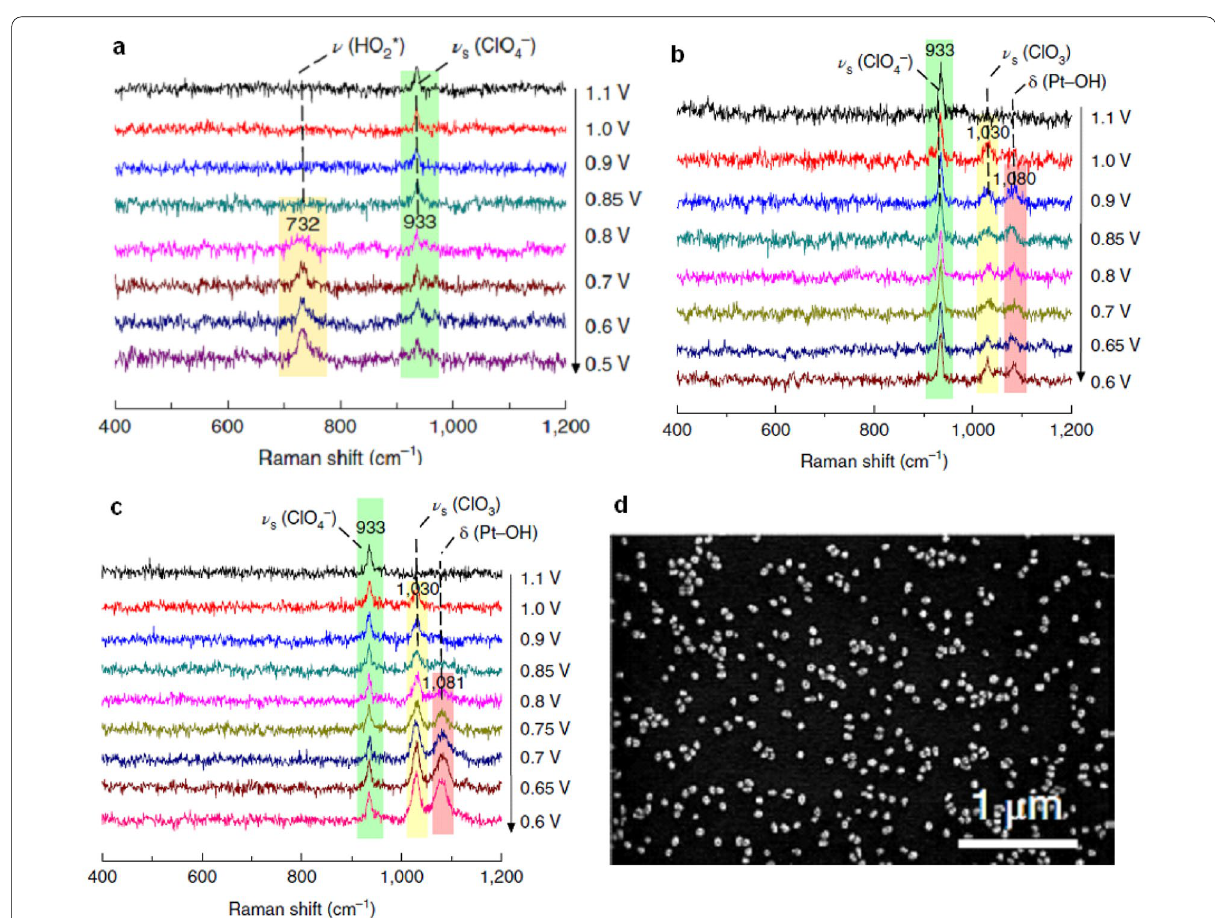
Fig. 6 SHINERS of the ORR in a 0.1 M HClO 4 solution saturated with O 2 at the a Pt(111) electrode surface, b Pt(100) electrode surface, and c Pt(110) electrode surface, d The scanning electron microscopy (SEM) images of a Pt(111) single-crystal electrode surface modified with Au@SiO 2 , reproduced with permission from [20]. Copyright (2018) Springer Nature